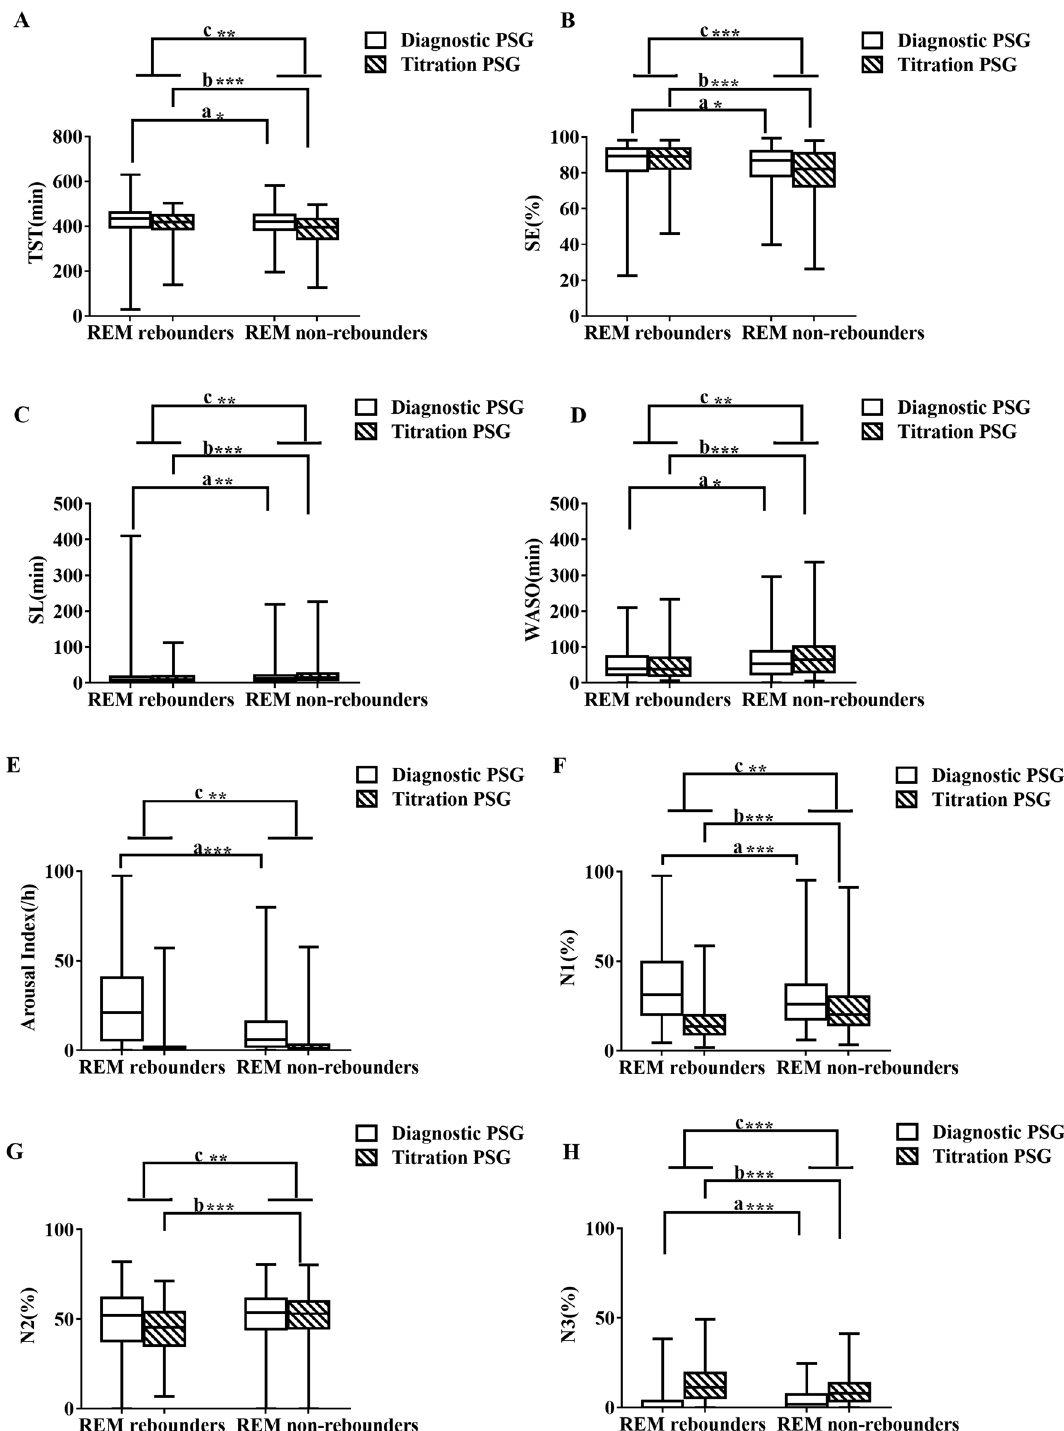
Figure 2. The changes from diagnostic PSG to pressure titration PSG between REM rebounders and non-REM rebounders. The figures showed the changes of diagnostic and pressure titration PSG in TST (A), SE ( B ), SL ( C ), WASO ( D ), Arousal Index ( E ), %N1 ( F ), %N2 ( G ), % N3 ( H ), % REM ( I ), AHI ( J ), Mean duration of apneas and hypopneas ( K ), Nadir SpO 2 ( L ), Mean SpO 2 ( M ), ODI ( N ) between REM rebounders and non-REM rebounders. a, comparison of diagnostic PSG parameters between REM rebounders and non-REM; b, comparison of pressure titration PSG parameters between REM rebounders and non–REM rebounders; c, comparison of the changes from pressure titration to diagnostic PSG parameters between REM rebounders and non-REM rebounders and * p < 0.05, **p < 0.01, ***p < 0.001. AHI apnea–hypopnea index, BMI body mass index, ODI oxygen desaturation index, PSG polysomnography, REM rapid eye movement sleep, SE